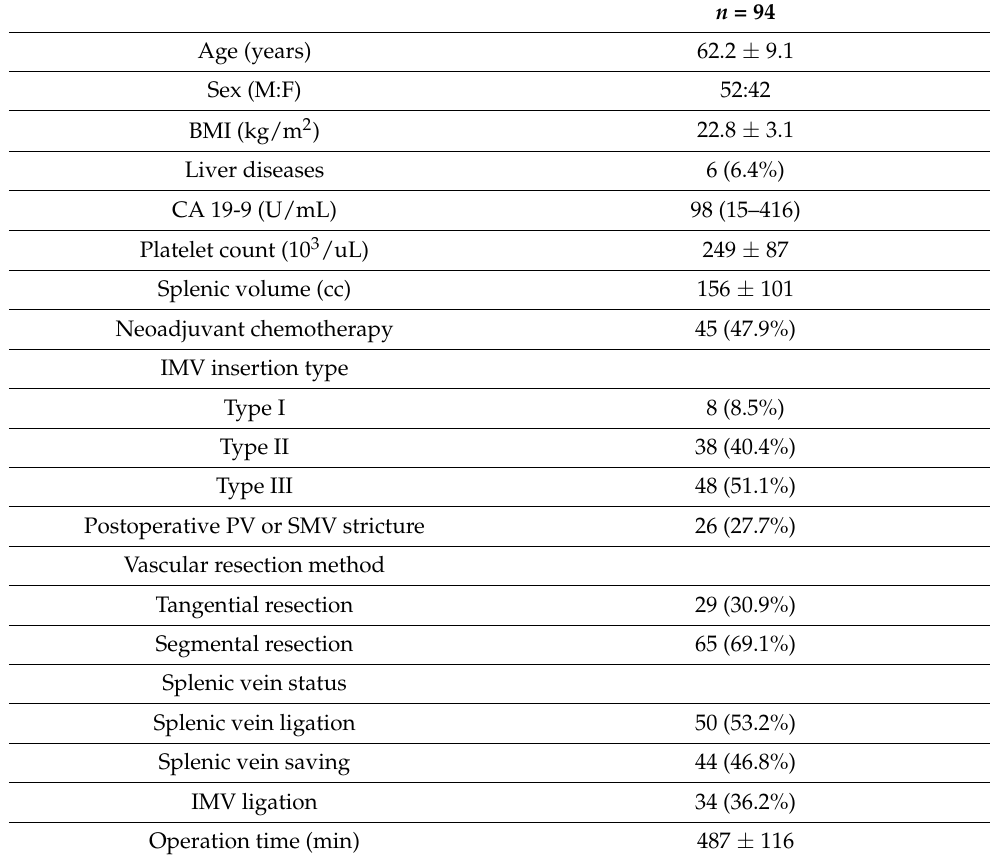
Table 1. Basal characteristics of the enrolled